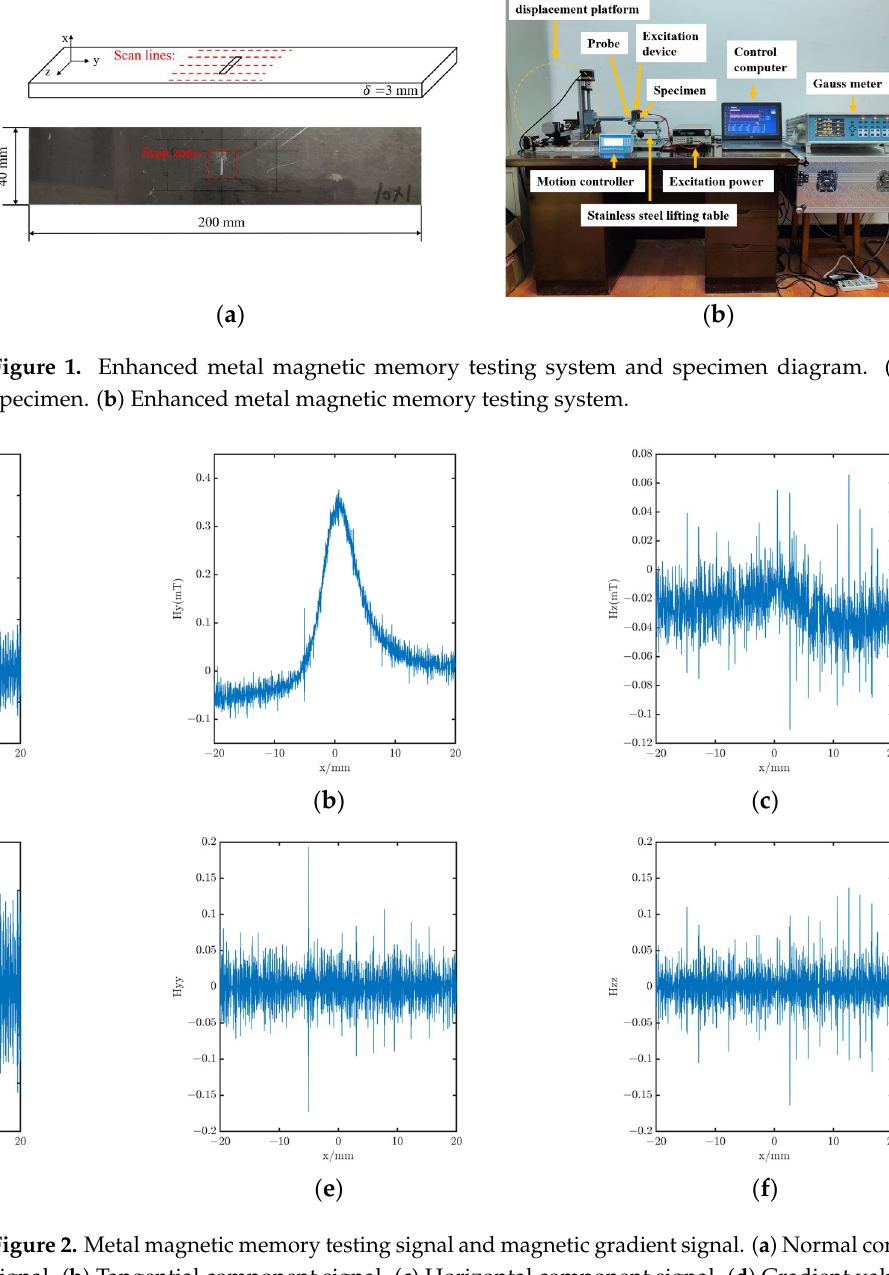
Figure 2. Metal magnetic memory testing signal and magnetic gradient signal. ( a ) Normal compo- nent signal. ( b ) Tangential component signal. ( c ) Horizontal component signal. ( d ) Gradient value of the normal component signal. ( e ) Gradient value of the tangential component testing signal. ( f ) Gradient value of the horizontal component testing signal.